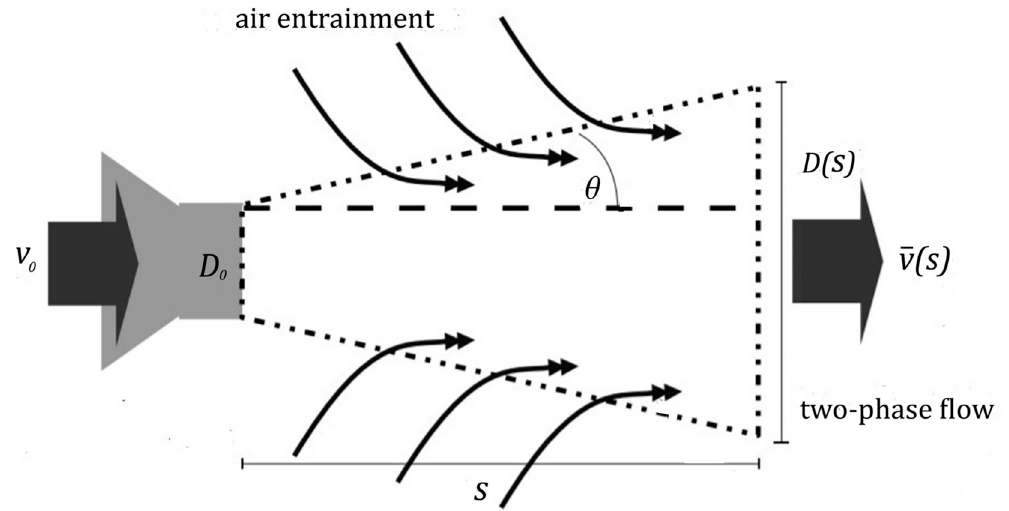
Figure 3. Diagram of the mass entrainment process (adopted from [28]).